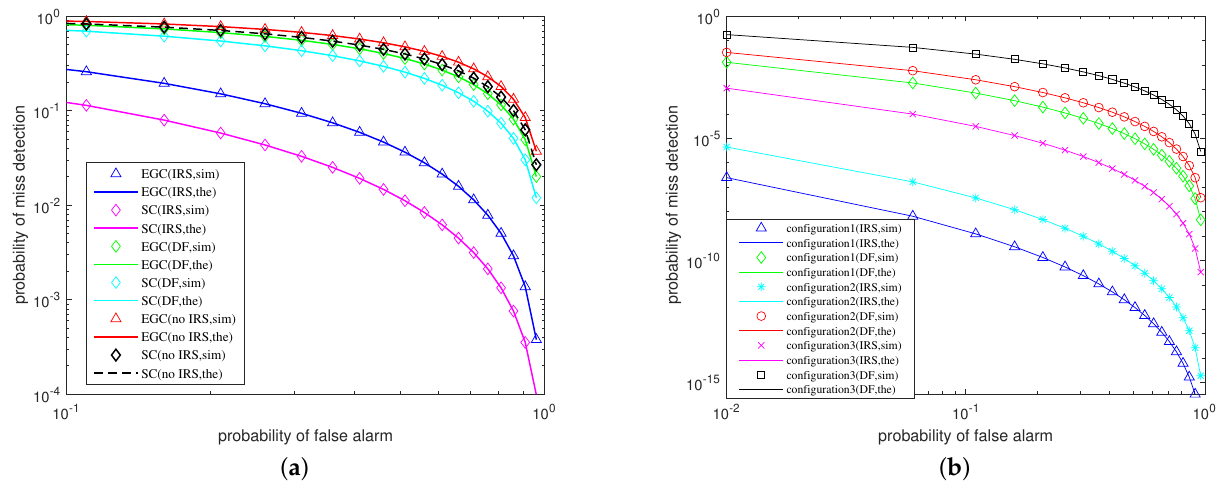
Figure 5. ( a ) ROC curves for the IRS-enhanced CSS, the DF relay CSS and the no IRS CSS; ( b ) ROC curves for different system